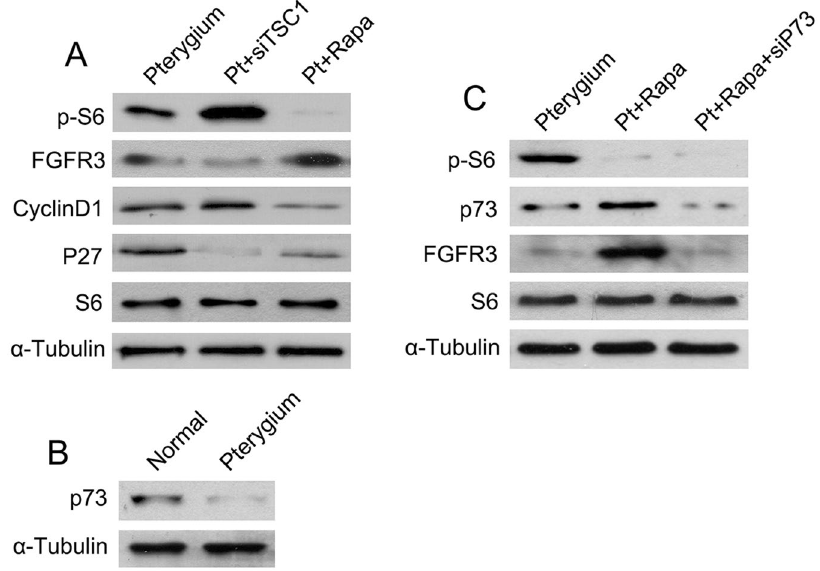
Figure 5. mTORC1 activation in pterygium inhibited FGFR3, thus promoting cell proliferation by targeting p73. ( A ) Western blot analysis in cultured pterygium epithelial cells after treatment of TSC1 siRNA or rapamycin. ( B ) p73 expression in pterygium and normal conjunctiva. ( C ) Western blot analysis of p-S6, p73 and FGFR3 in cultured pterygium epithelial cells after treatment of rapamycin with or without p73 siRNA transfection.